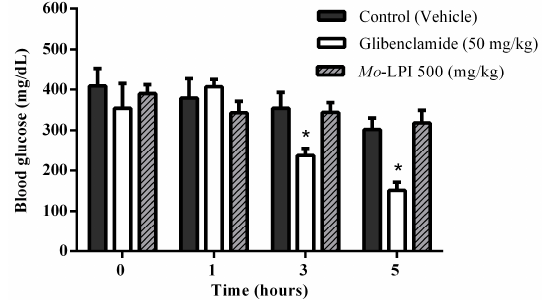
Figure 6. Effect of oral administration of Mo -LPI on blood glucose level in alloxan-induced diabetic mice. Values are means ± S.E.M. ( n = 10). Control: vehicle (0.05 M Tris-HCl, pH 7.5, 0.15 M NaCl). * Significant ( p < 0.01) difference when compared with the corresponding value of the control at the same time. The effect of repeated i.p. administration of Mo -LPI on blood glucose levels is presented in